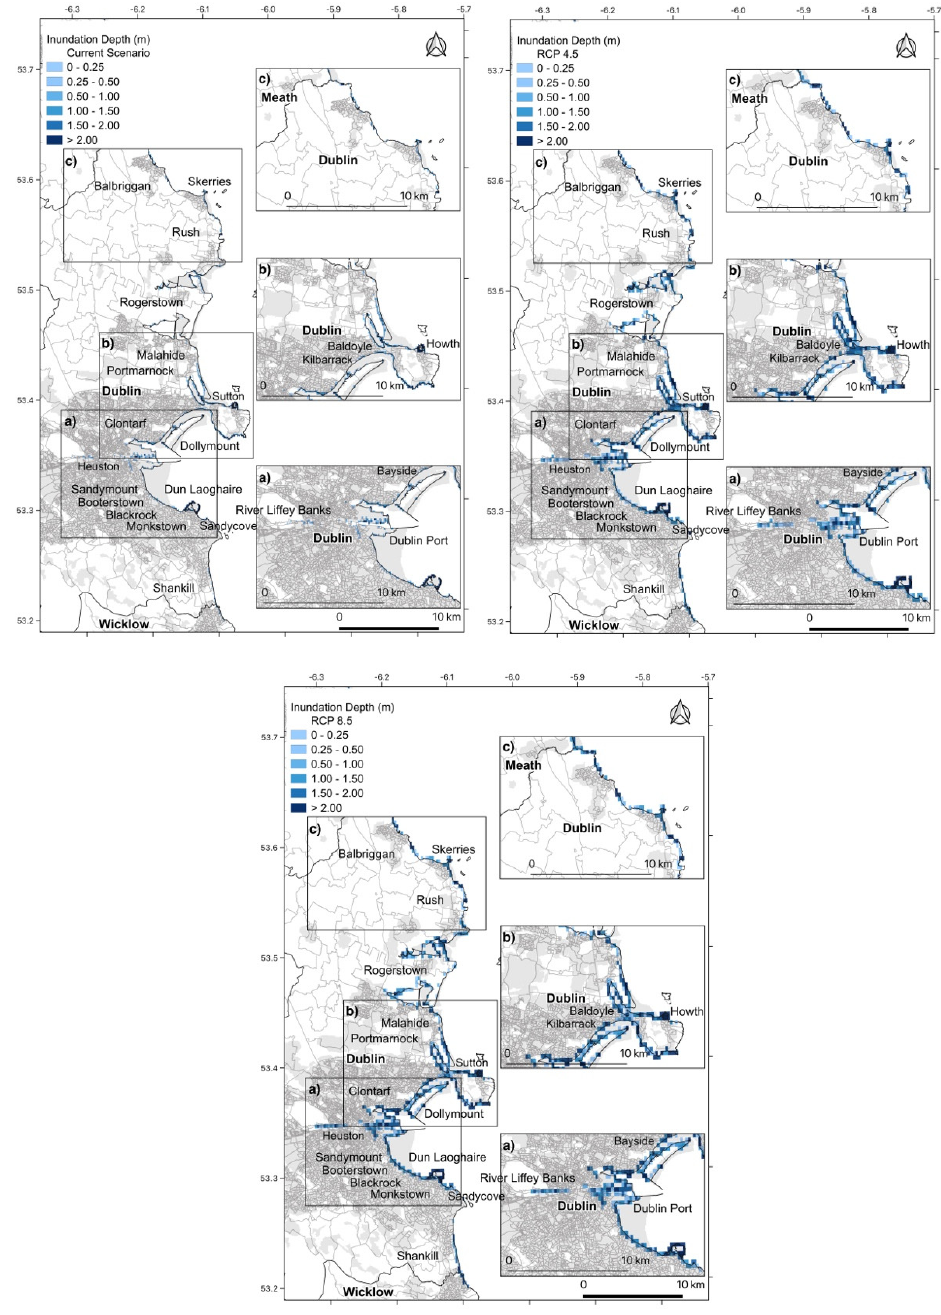
Figure 3. Coastal inundation in terms of inundation depth (m) across County Dublin for the current period ( upper left panel), under RCP 4.5 ( upper right panel) and RCP 8.5 ( lower panel) for 2100 (estimated sea level rise of 0.45 and 0.81 m, respectively); ( a ) Dublin city; ( b ) Howth and Malahide area ( c ) northern part of the County. Urbanized areas in 2020s (current period) and 2100 (RCP 4.5 and 8.5) are in grey. The inundation depth is calculated as the maximum value reached at any time and by any model output cell within the 100 m square cell. Regular font: suburbs; bold: county name.